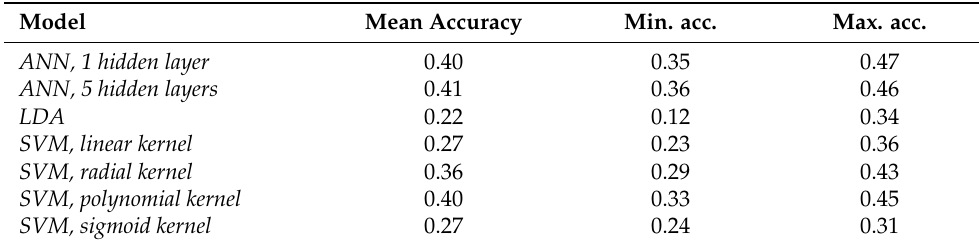
Table 6. Mean (minimum, maximum) accuracies achieved by different classifier models to assign a read to the correct viral order in 10 simulation runs.